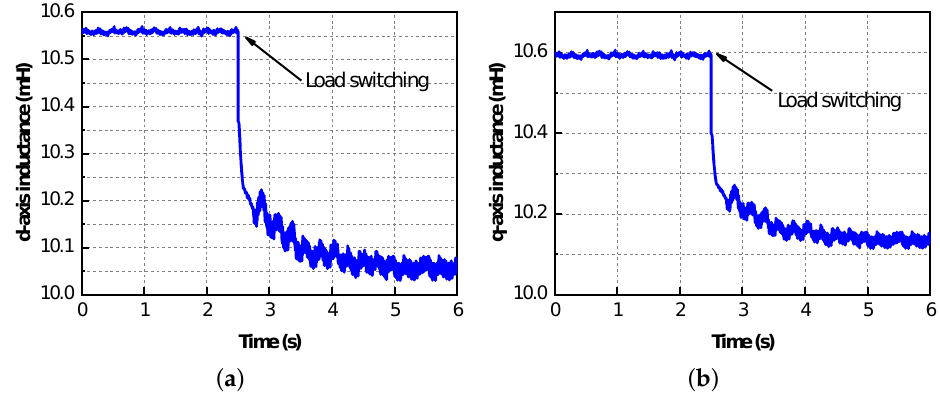
Figure 29. Experimental results.( a ) d-axis inductance and ( b ) q-axis inductance. The experiment with constant inductance value is also conducted. It is found that